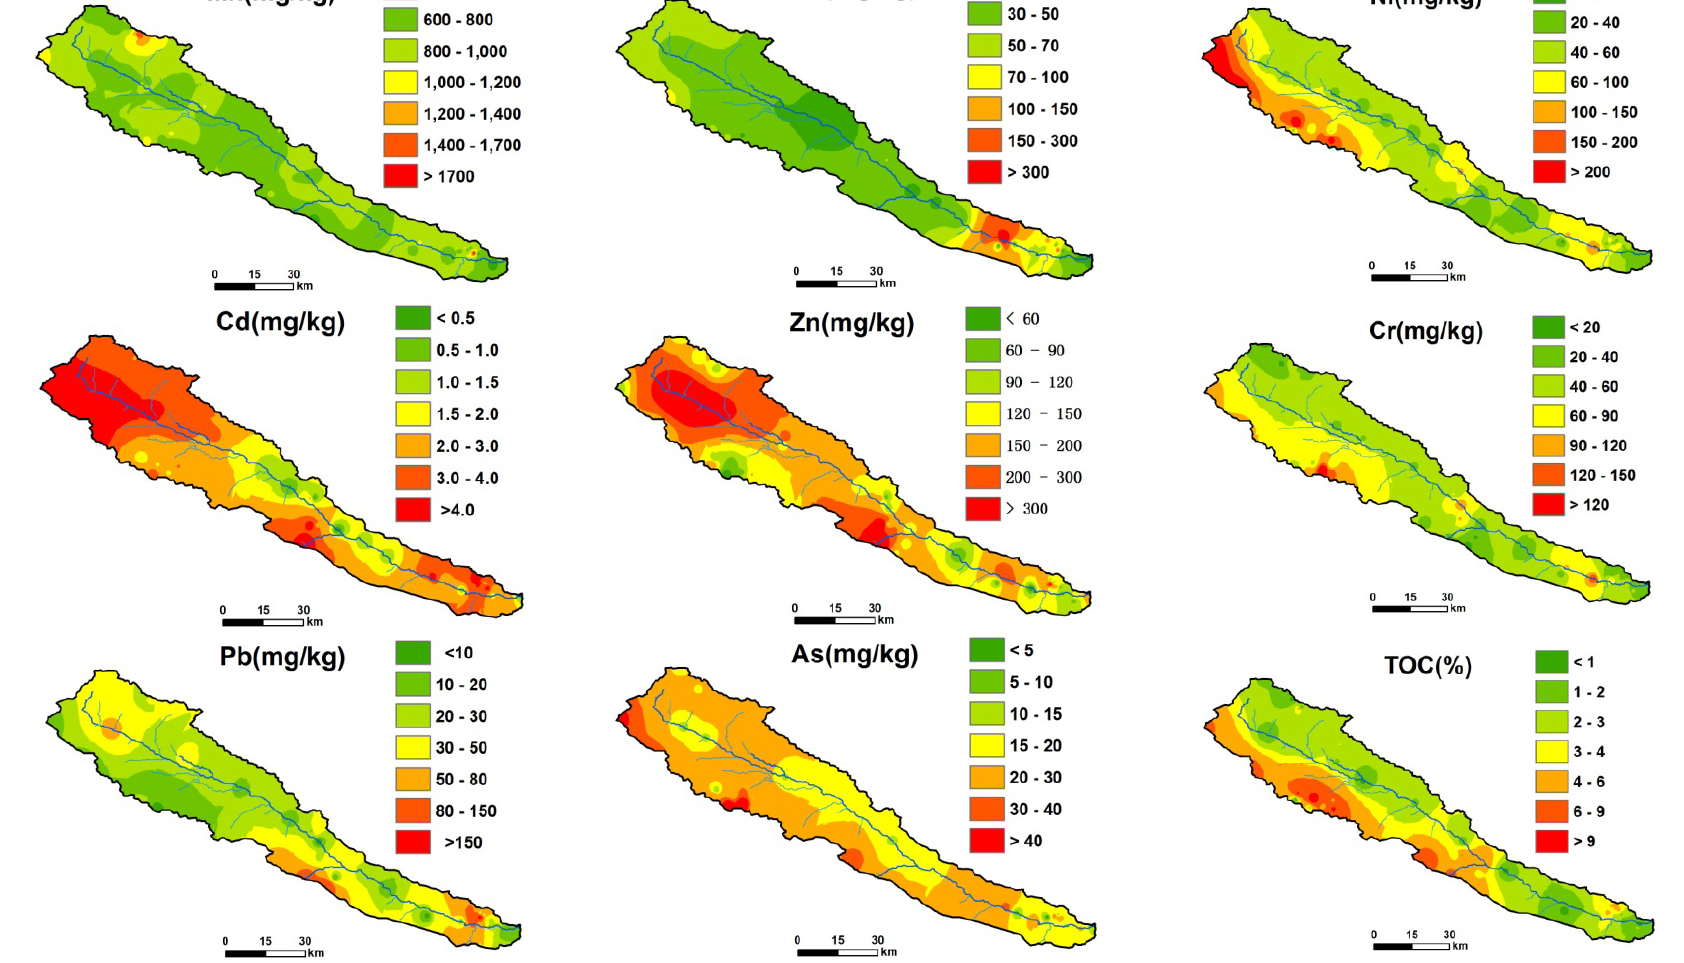
Figure 5. Spatial distribution of HMs and TOC in the upper reaches of the Heihe River.